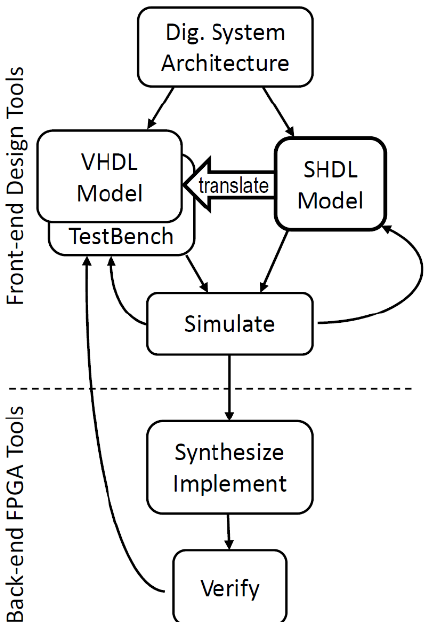
Figure 2. Proposed pedagogical design flow: SHDL models automatically translated to VHDL allow seamless integration into the existing design process.